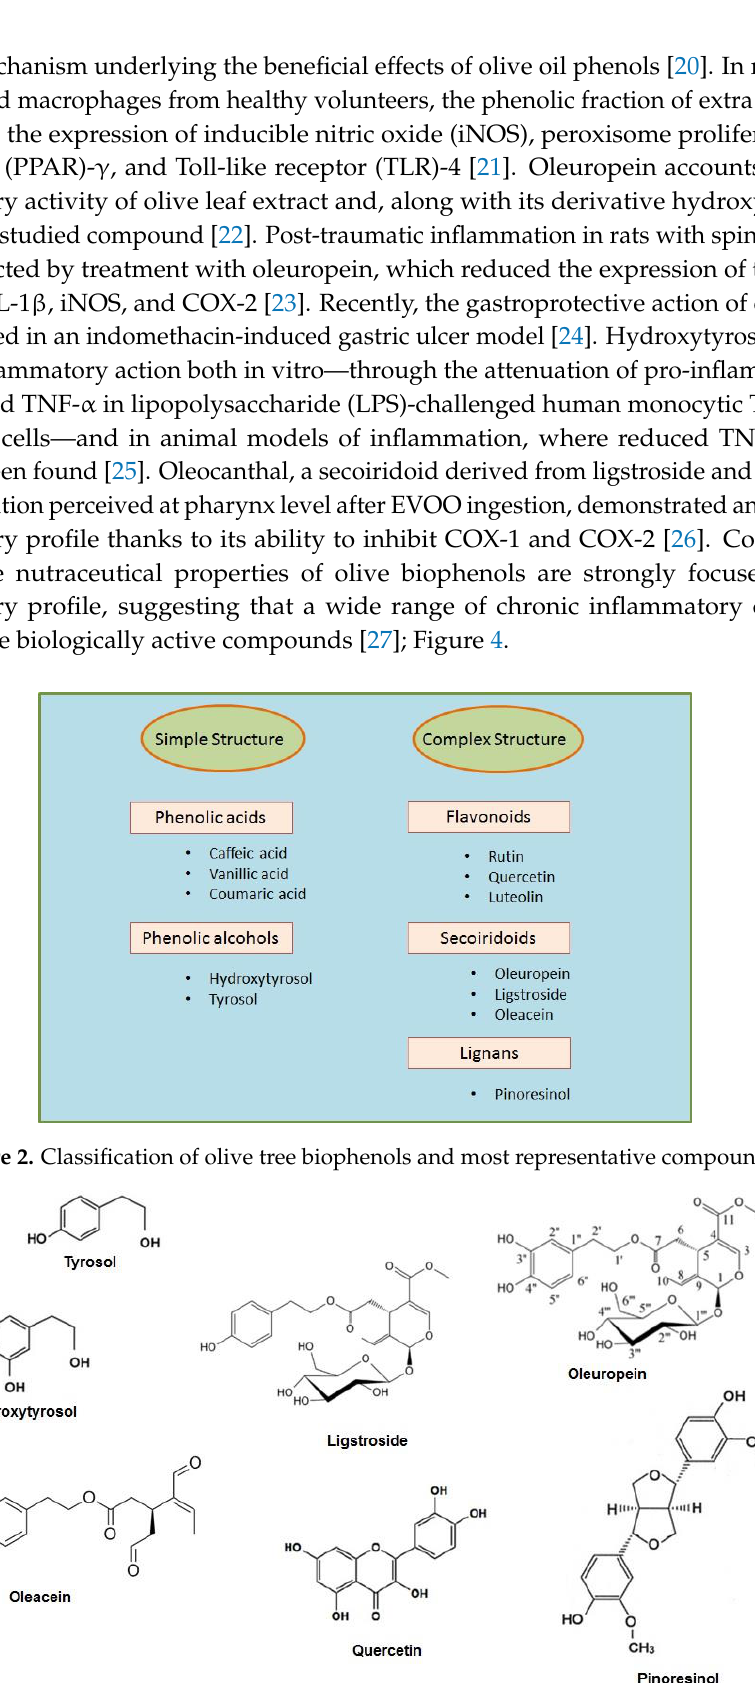
Figure 3. The chemical structure of the main phenolic compounds derived from olive tree (adapted from